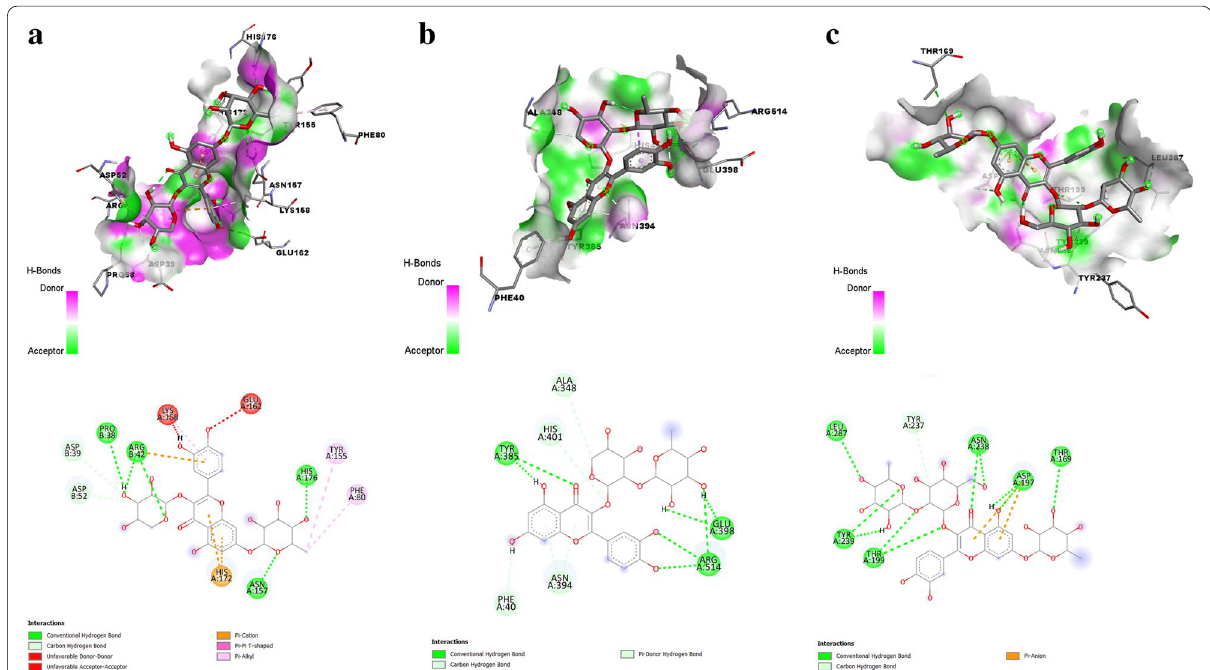
Fig. 5 Interaction of a Quercetin 3-O-arabinoside 7-O-rhamnoside with papain-like protease. b Quercetin 3-[rhamnosyl-(1- > 2)-alpha-L-arabinopyranoside] with spike protein receptor binding domain. c Quercetin-3-neohesperidoside-7-rhamnoside with 3C-like protease